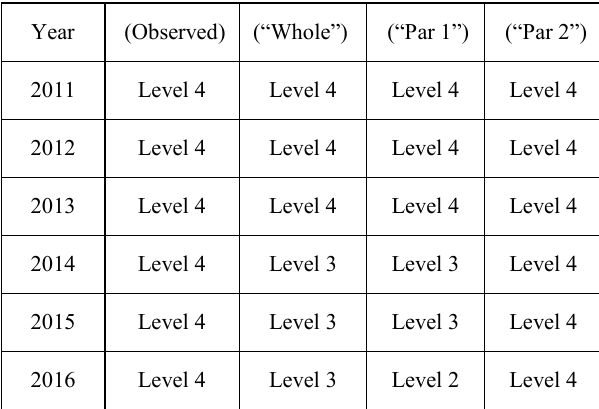
Table 7. LIMeco levels for the case study, comparison between observations and simulation